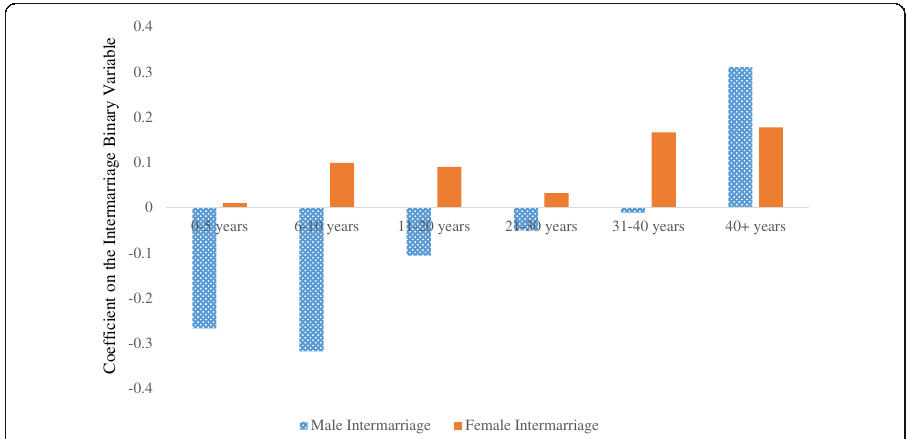
Fig. 2 Household specialization: by duration of marriage. Source: 2010 ACS. Bar heights show the difference in specialization between intermarried and intra-married households, conditional on all observables introduced in Section